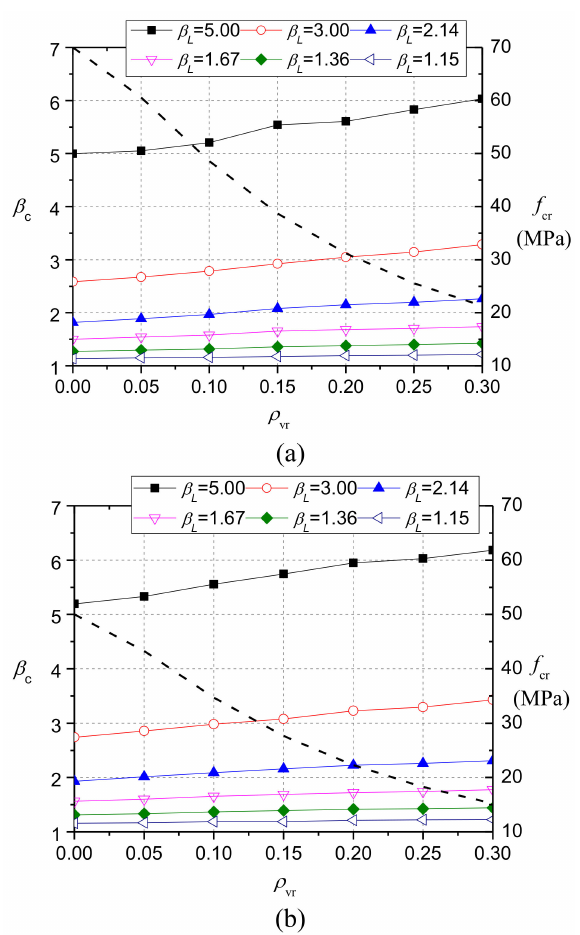
Figure 23. E ff ect of rubber content on the value of β c when the compressive strength of reference NC is the same: ( a ) 70 MPa; ( b ) 50